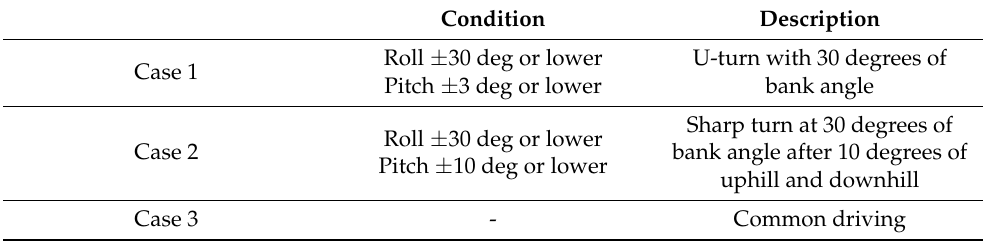
Table 6. Acceleration/angular velocity estimator validation